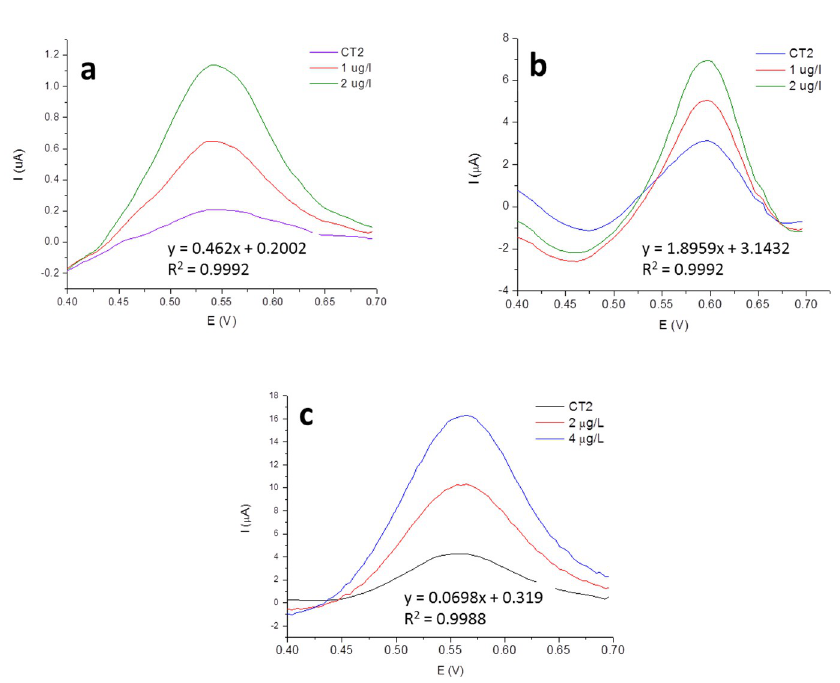
Figure 5. Voltammograms obtained for Hg quantification in sample CT2 using MW T -SGE ( a ), MW T -AuNPs-GCE ( b ) and P T -AuNPs-GCE ( c ) with the standard addition method.